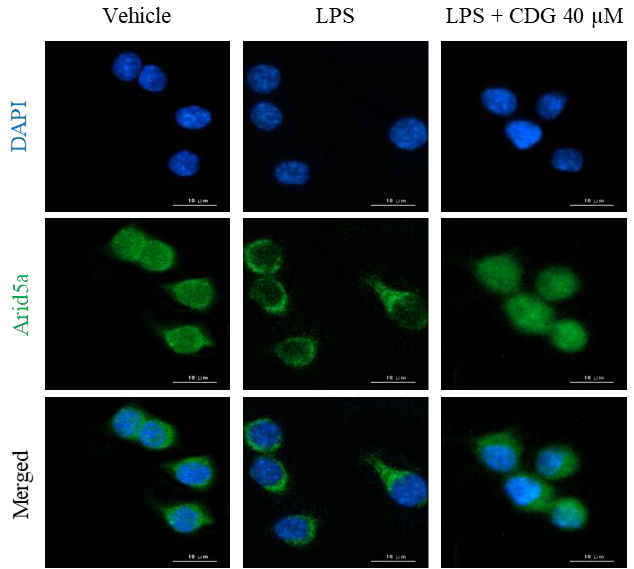
Figure 6. Effect of CDG on Arid5a activation. The ImKC cells were treated with CDG (5, 10, 20, and 40 μM) for 2 h and stimulated by LPS (1 μg /mL) for 3 h. Immunofluorescence staining for Arid5a (green) and compared with DAPI (blue). Scale bars: 10 μm. CDG, catechin - 7,4′ - O -digallate; ImKC, immortalized mouse Kupffer cells; LPS, lipopolysaccharide; Arid5a, AT-Rich interaction domain 5a; DAPI, 4′,6 -diamidino-2-phenylindole. Scale bar = 10 µ M.